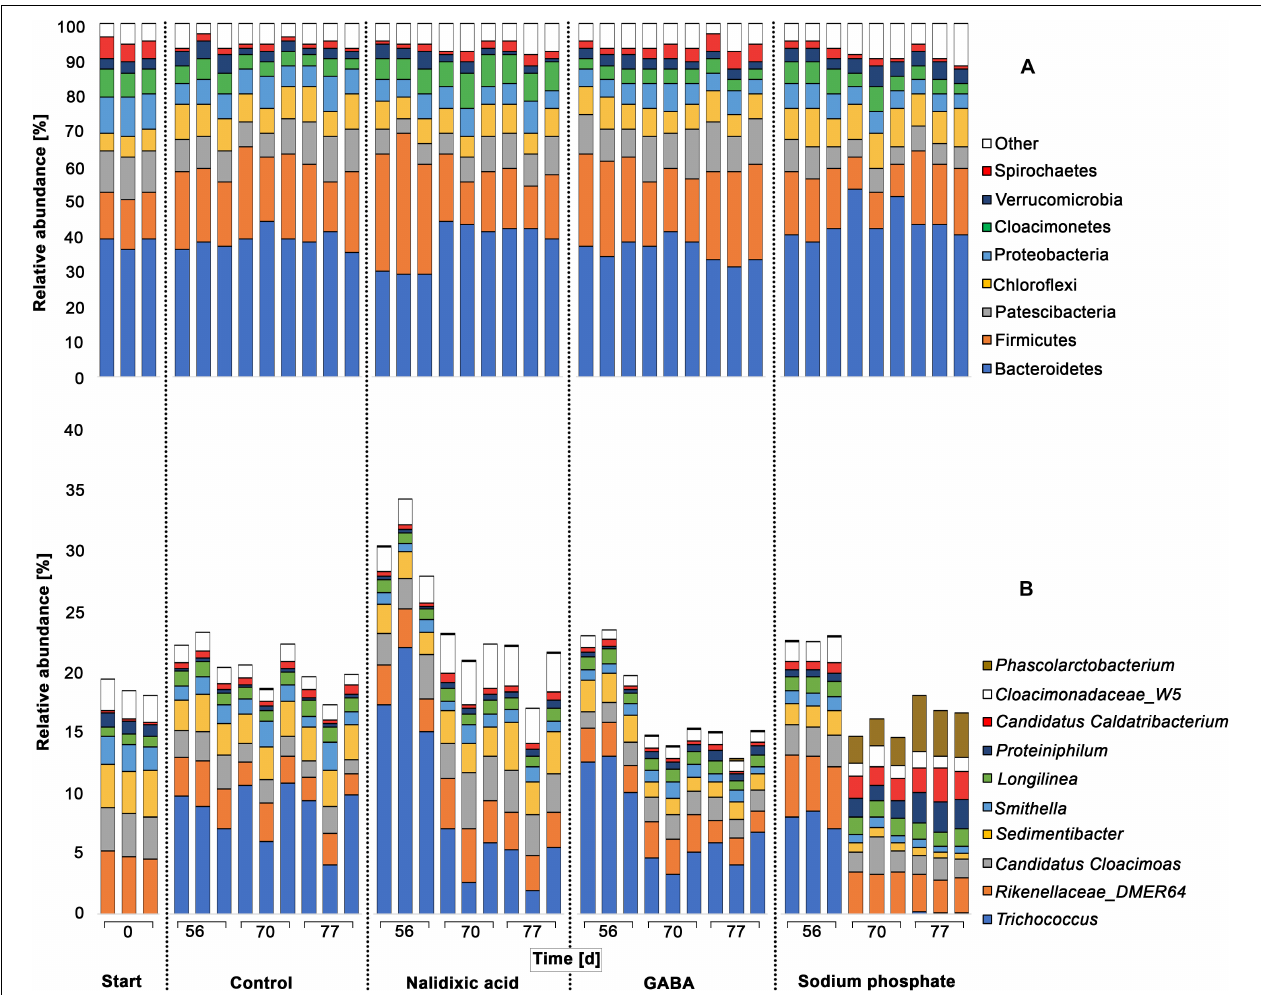
FIGURE 5 | Taxonomic profiles of chemically stressed digester microbiomes: Taxonomic profiles are shown for all experiments (perturbation with nalidixic acid, γ -aminobutyric acid [GABA], sodium phosphate and the control). Results are shown for the 8 most abundant phyla (A) and 10 most abundant genera (B) . For determining the most abundant phyla and genera, they were sorted after summing up their relative abundancies in all samples. The 16S-rRNA gene amplicons were analyzed for the seed sludge (start) and at three time points during treatment (days 56, 70, and 77). For each timepoint 3 sludge samples were taken and